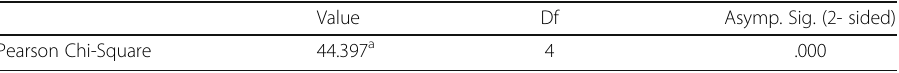
Table 1 Chi-Square analysis of the learners ’ perceptions towards the explicit grammar instruction and corrective feedback Value Df Asymp. Sig. (2- sided) Pearson Chi-Square 44.397 a 4